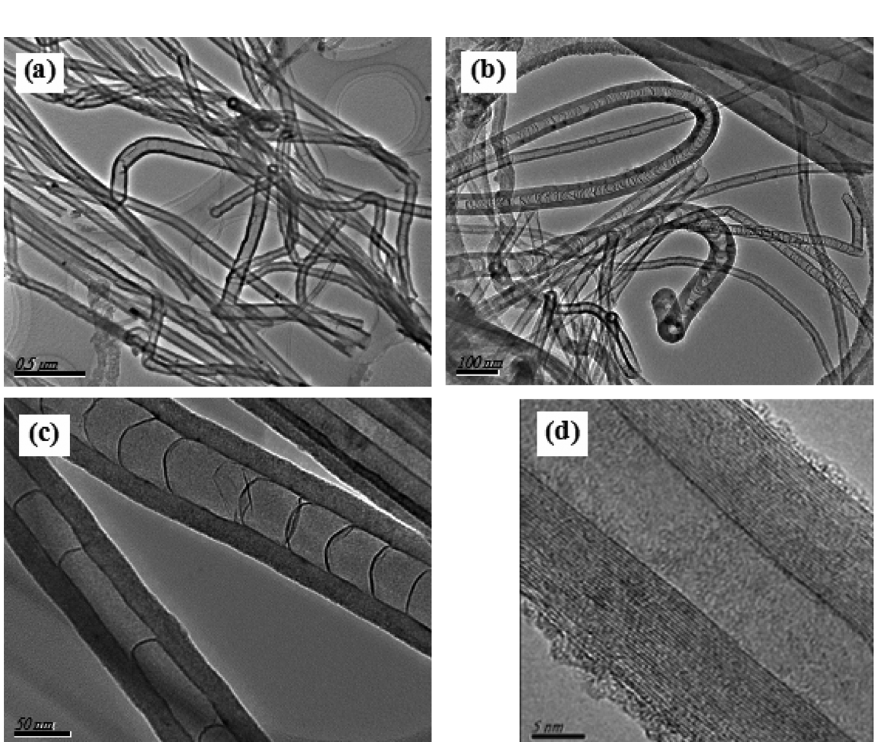
Figure 4: SEM images of CNTs grown on different treated sub- strates with different nickel film thickness (a) 5 nm, (b) 10 nm, (c) 15 nm, (d) 20 nm.